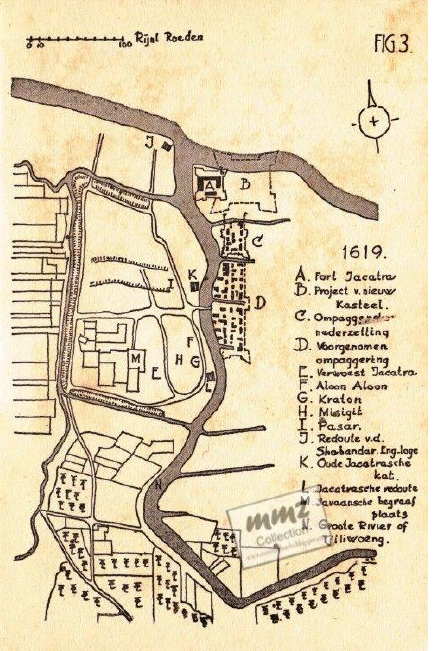
Figure 5. 1619 map shows Jayakarta after the Dutch annexed the city to the south. Het Voormalige Batavia